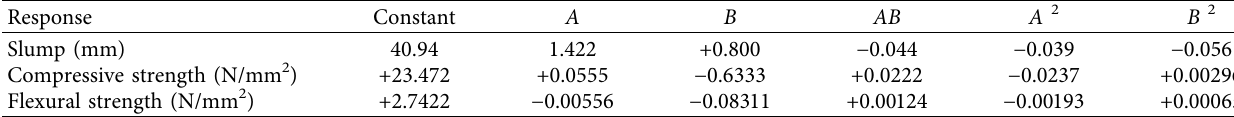
Table 2: Mathematical equations of the responses.